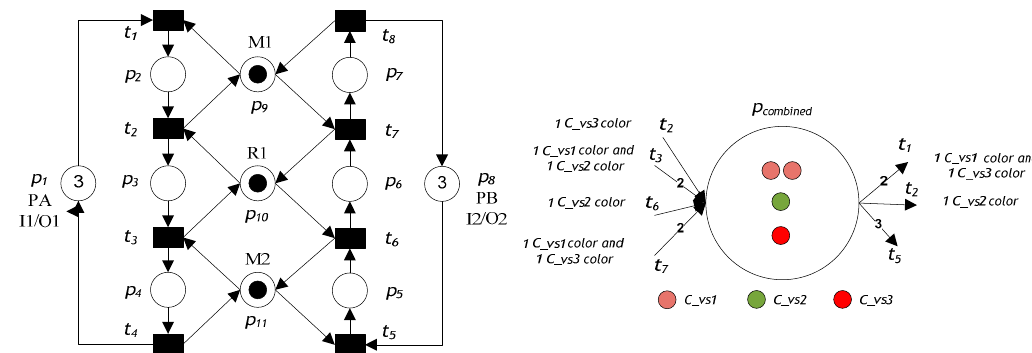
Figure 1. Colored controlled S 3 PR Petri net model Algorithm 2. Figure 7. Colored controlled S 3 PR Petri net model Algorithm 2.